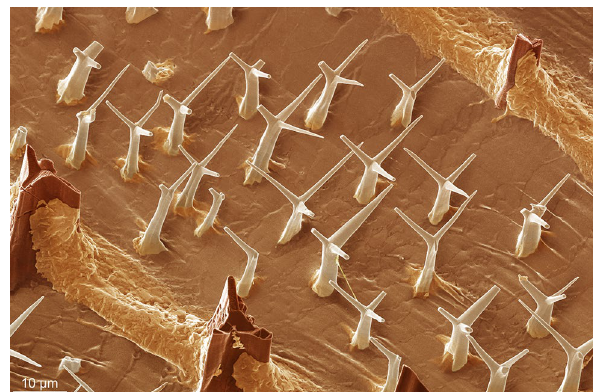
Figure 1. View of the shell surface of Catillopecten natalyae , decorated with low order aerials with their characteristic three branched morphology occupying the area between two ribs. The aerials are all cooriented and nearly evenly spaced. SEM coloured image, where the different structures (high-, low-order aerials and secondary deposits) have been applied different colors. See also Supplementary Fig.